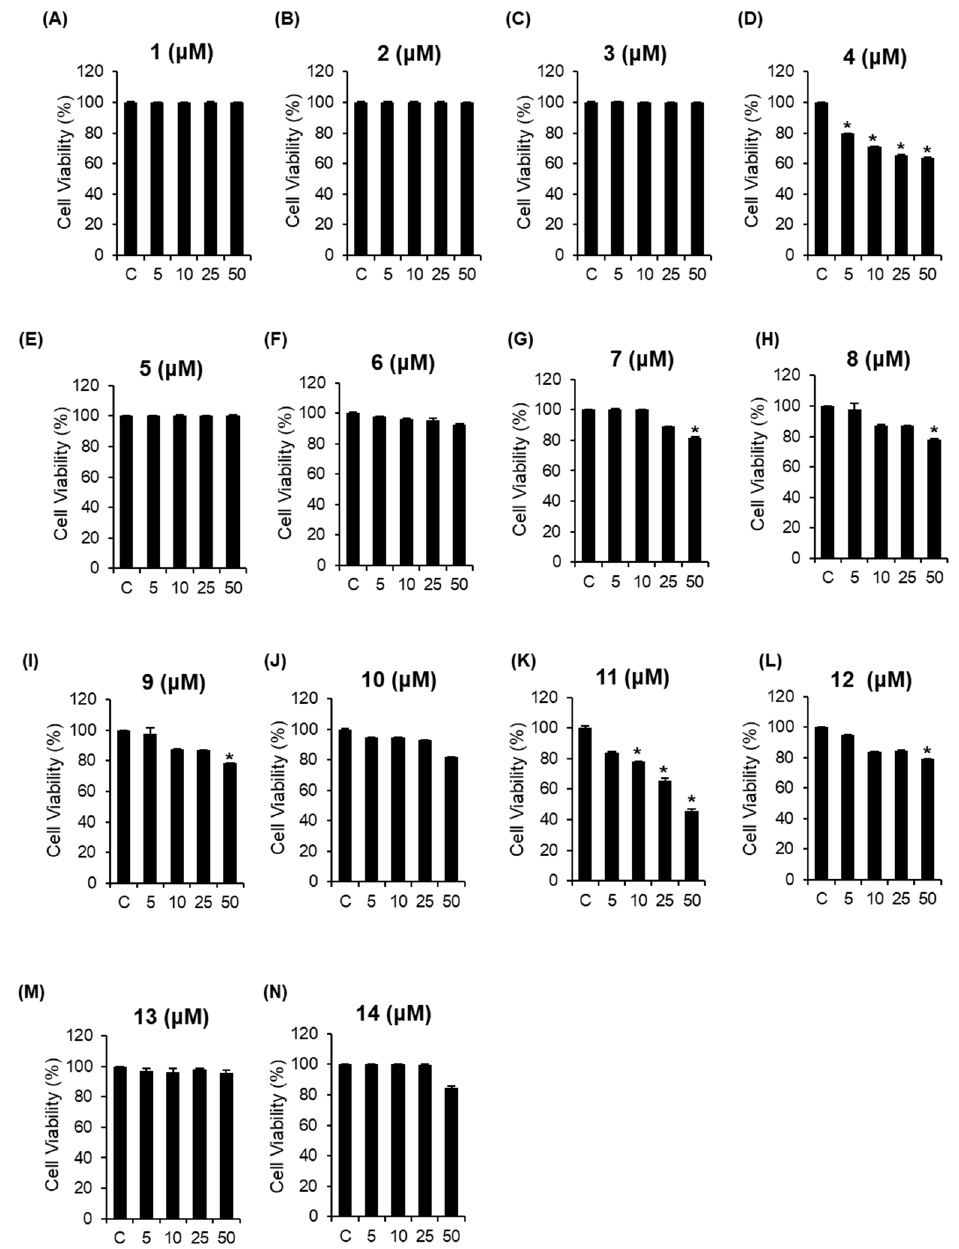
Figure 3. Comparison of the inhibitory effects of the isolated compounds 1–14 ( A–N ) on A2780 human ovarian carcinoma cells. * p < 0.05 compared to the value obtained for non-treated cells. Cell viability assays were done in triplicate for each assay and repeated at least thrice.